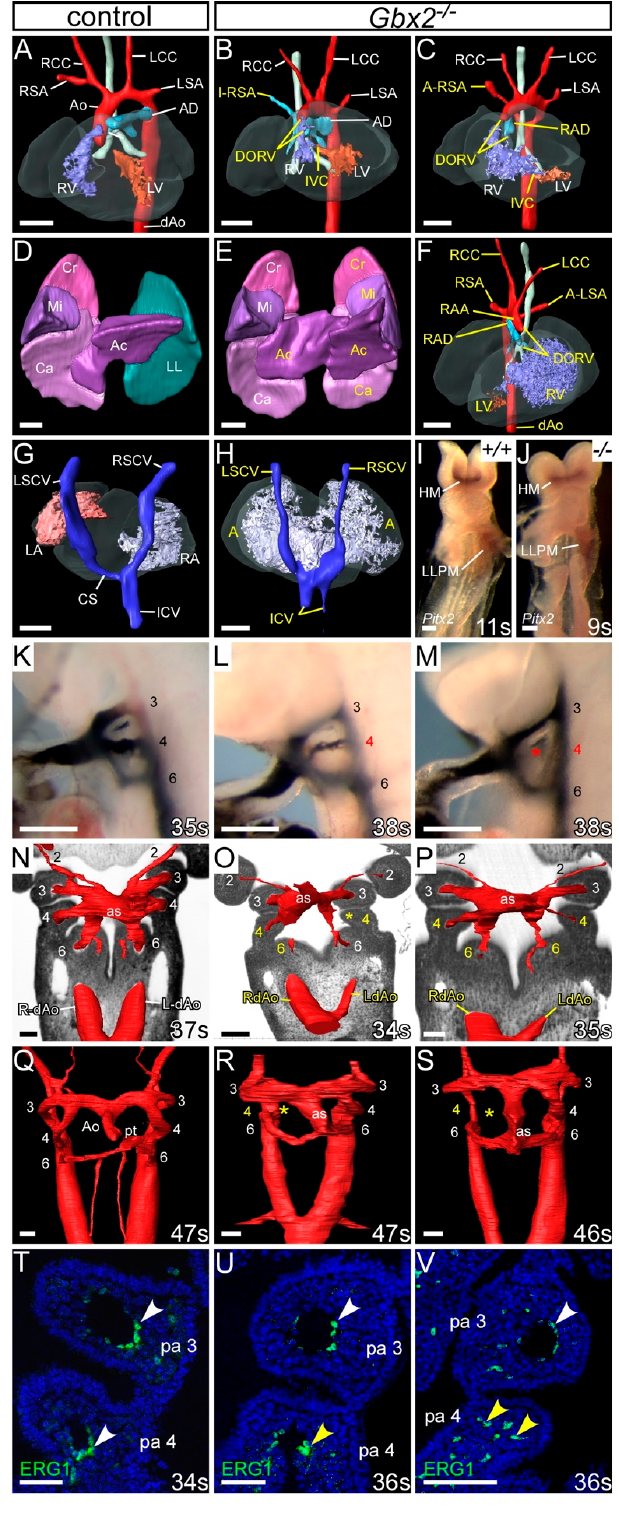
Figure 2. Cardiovascular defects in Gbx2 –/– embryos. ( A–H ) 3D reconstructions from MRI datasets of E15.5 embryos. ( A ) Gbx2 +/+ control embryo with normal heart and aortic arch arteries. ( B,C ) In Gbx2 –/– embryos (n = 25), defects seen include double outlet right ventricle (DORV) with interventricular communication (IVC), retro-oesophageal aberrant right subclavian artery (A-RSA), isolated RSA (I-RSA) and right-sided arterial duct (RAD). ( D–H ) Left-right patterning defects were observed in a